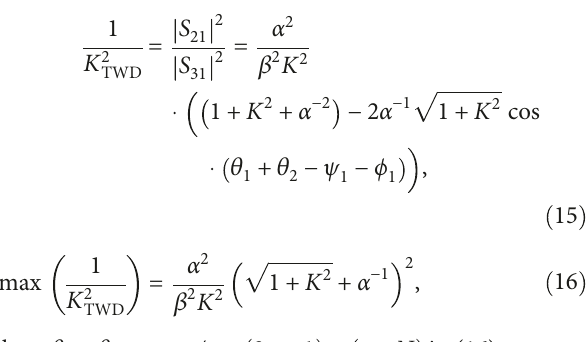
Figure 3: Computation on the power division ratio with C = 7 dB, ψ = − 90 ° , ψ = ψ = − 180 ° , and ϕ = ϕ = 115 52 ° . The power 1 2 1 2 3 and the TL1 and TL2 phase delay is division ratio is 1/ K 2 TWD θ + θ 1 2